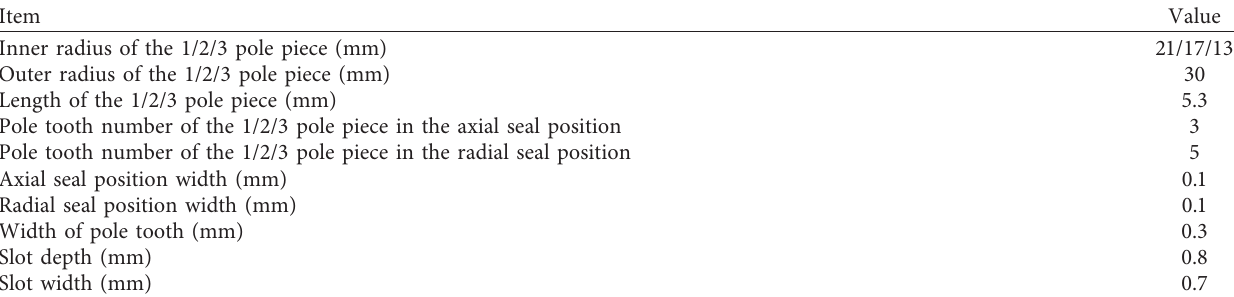
Figure 2: The equivalent magnetic Table 1: The parameters of converging stepped magnetofluid seal with small clearance.